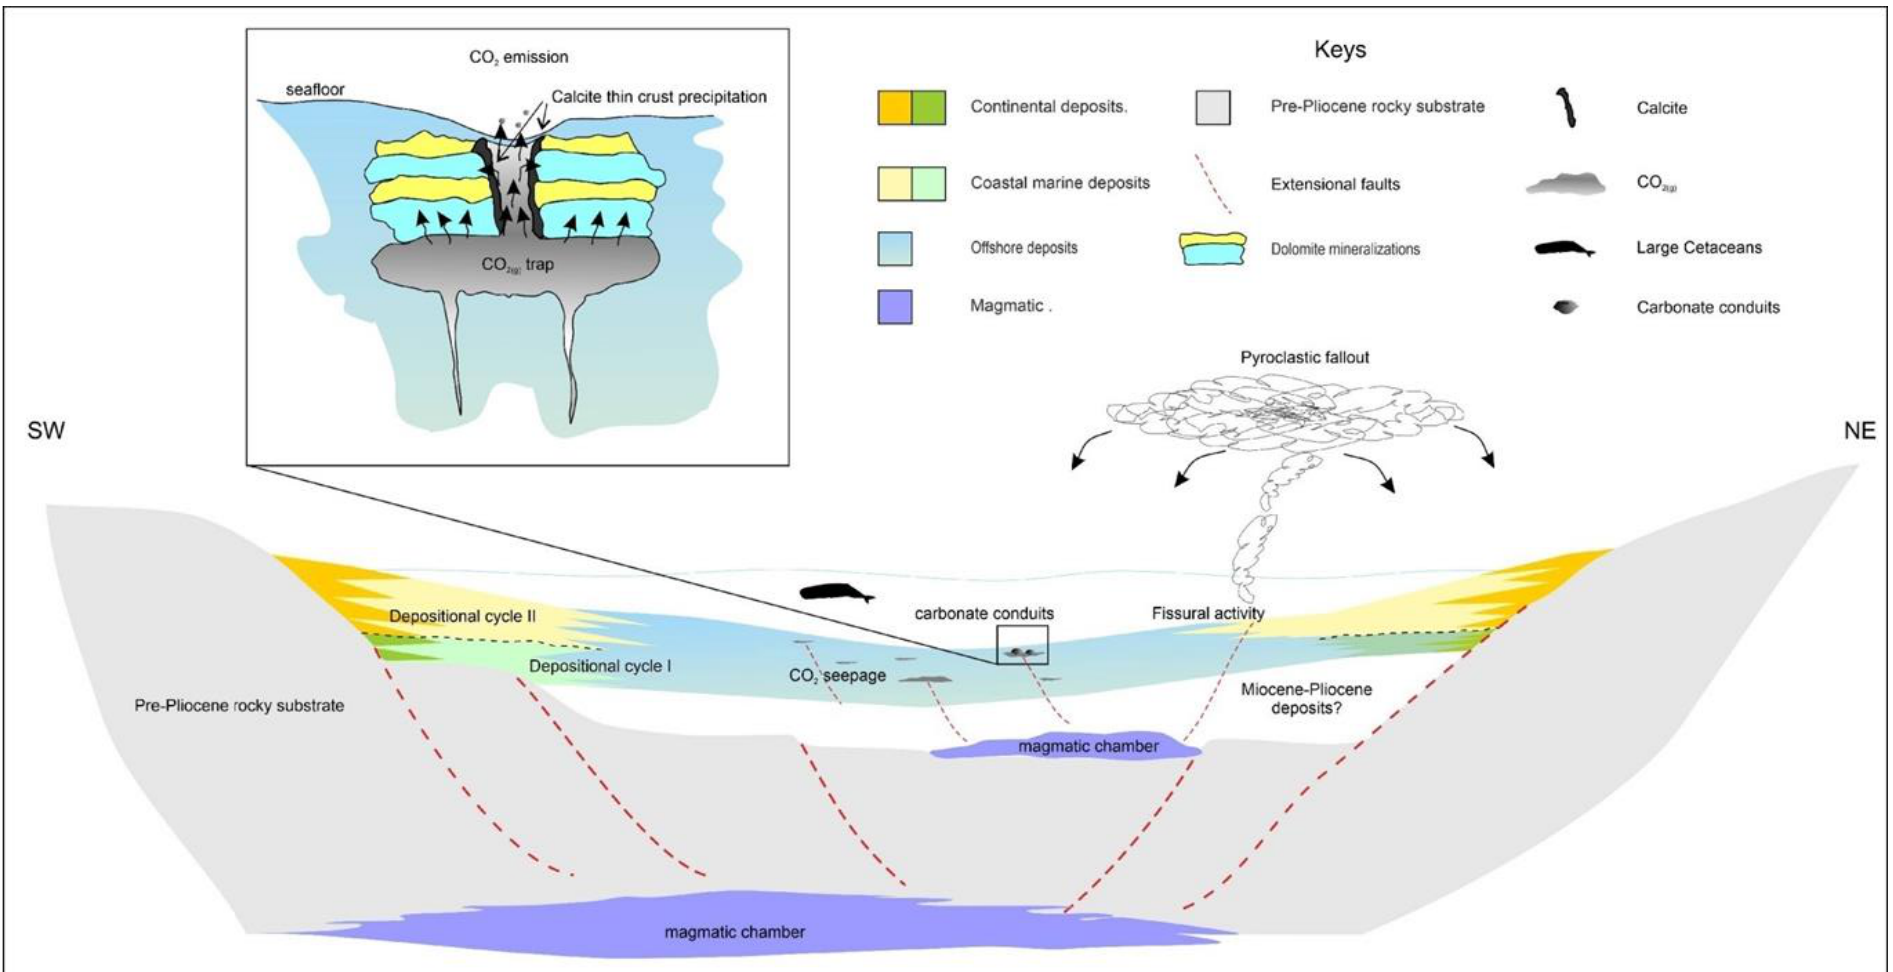
Figure 11. Proposed model for the origin of mineralised structures in relation to tectonic and volcanic